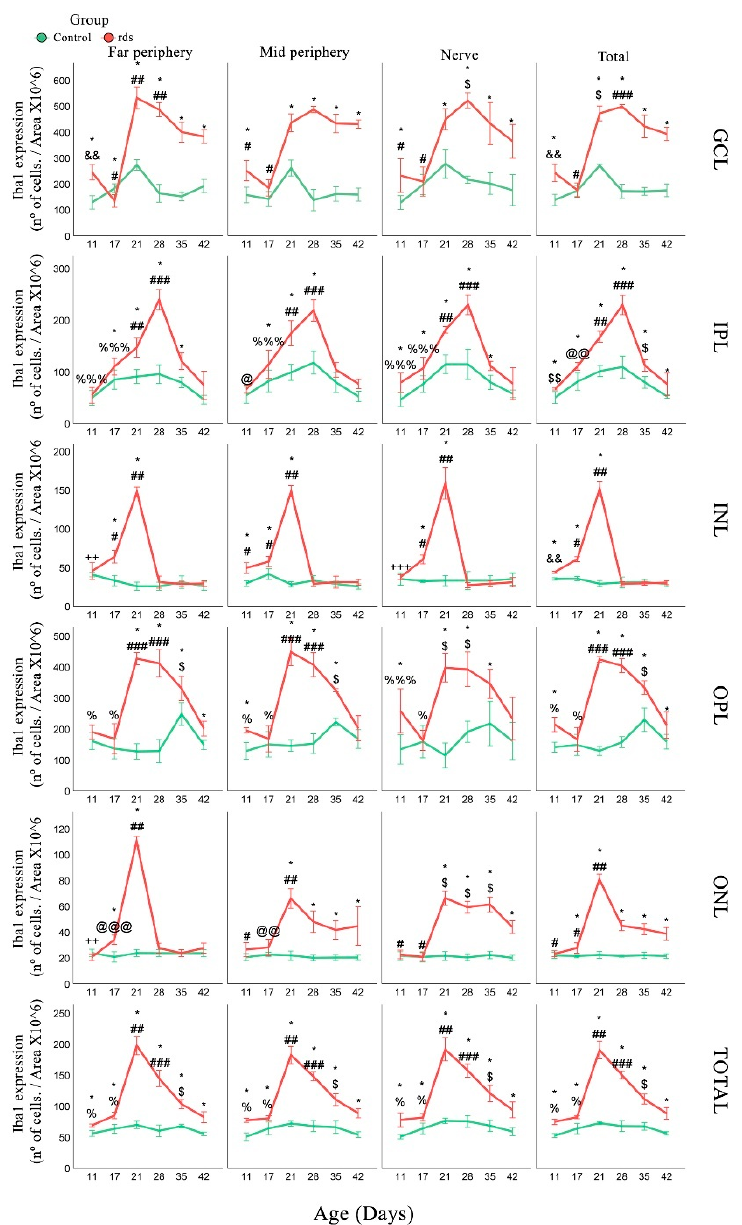
Figure 9. Changes in the number of microglia cells in rds retinas. Number of Iba1-positive cells/area × 10 6 in each retina layer in the three studied areas at PN11, PN17, PN21, PN28, PN35, and PN42 (* p < 0.05 vs. control at the same postnatal age; # p < 0.05 vs. rds PN21, PN28, PN35,